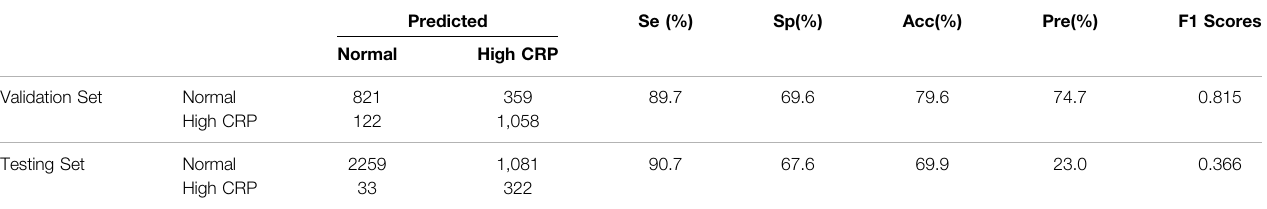
TABLE 2 | The Confusion Matrix of AI Model.